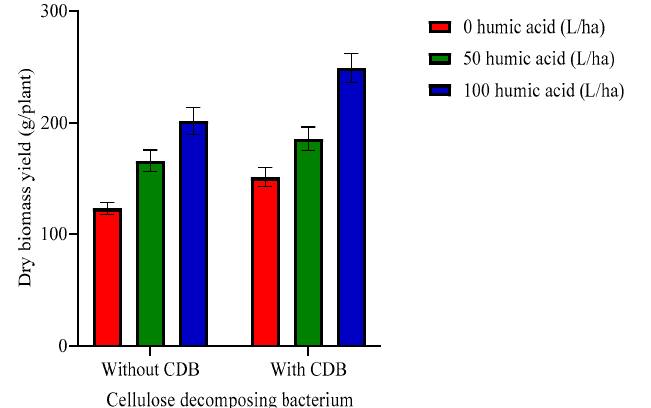
Figure 3. Interaction effects of humic acid levels with and without cellulose-decomposing bacterium on the dry biomass yield of squash plant in 2021 planting season. Bars indicate ± standard error, and error bars that are not overlapping each other indicate that the means are significantly ( p ≤ 0.05) different from each other.